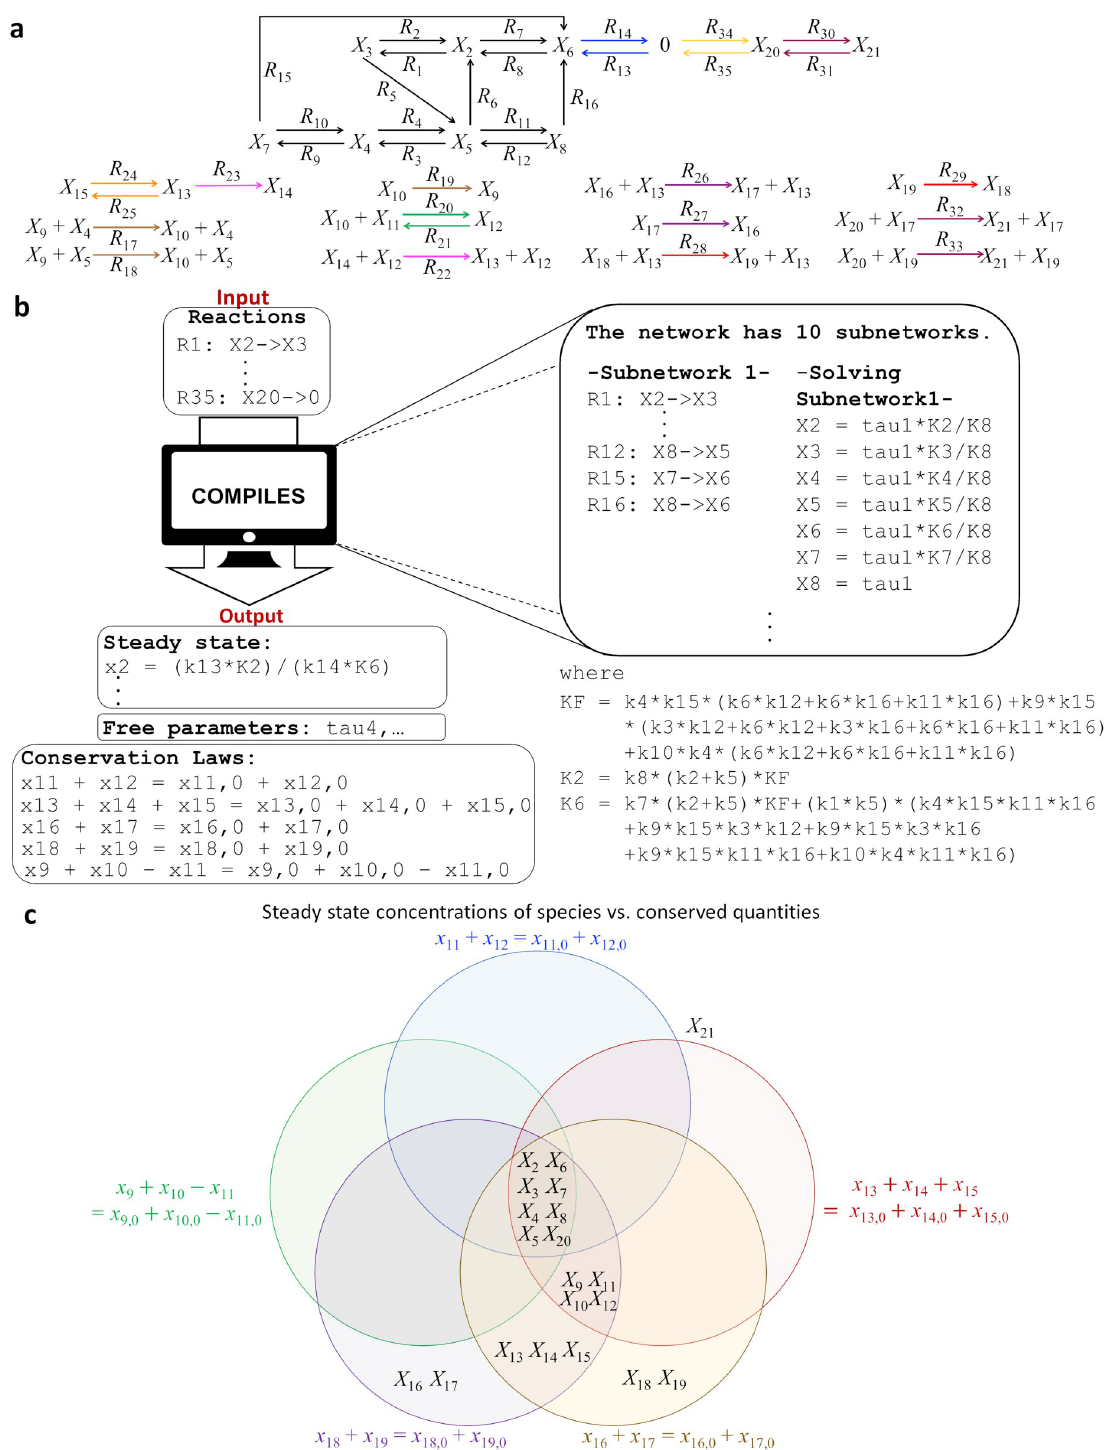
Fig 4. Derivation of analytic steady state of an insulin signaling network via computational package COMPILES. a The CRN of a mathematical model of insulin metabolic signaling pathway with 20 species ( X 2 , ... , X 21 ) and 35 reactions ( R 1 , ... , R 35 ). b A schematic diagram that describes the computational package COMPILES. As the insulin network is large, a computational package is developed to analytically derive the steady state of the network. If the users enter the reactions of the network (top left), then the package derives the steady state with the free parameters and the conservation laws of the network (bottom left). This is done by decomposing the network into independent subnetworks as outlined in Fig 1a and 1b and then deriving the steady state of each subnetwork as outlined in Fig 2 (right). Finally, the steady states of the subnetworks are combined to derive the analytic steady state of the original whole network as shown in